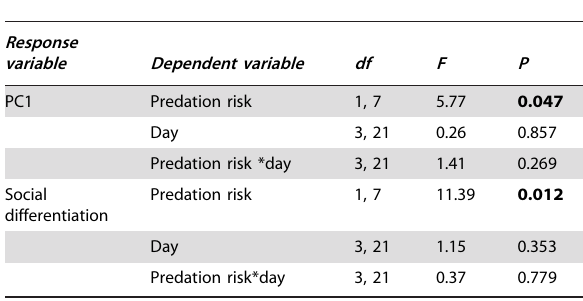
Table 2. MANOVA models testing the effects of predation risk, day and their interaction on PC1 and mean population social differentiation (both entered as repeated measures responses).